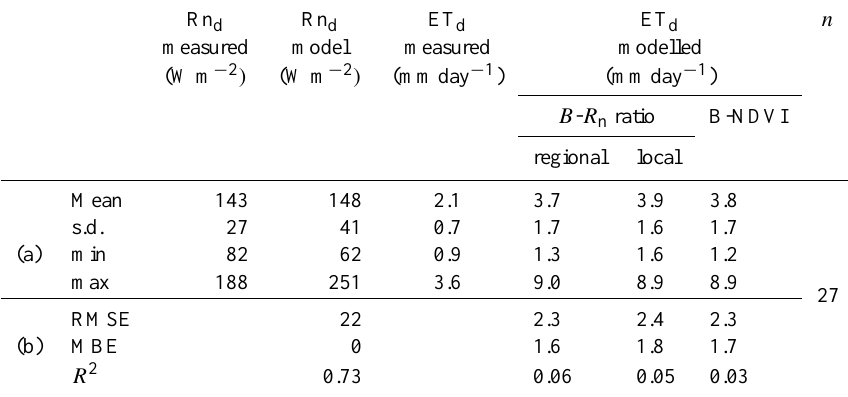
Table 3. (a): Descriptive statistics of daily net radiation (Rn d ) and daily evapotranspiration (ET d ) measured over the Scots pine stand, and AQUA MODIS Rn and ET d modelled using 3 methods: B - R n ratio regional, B - R n ratio local and B-NDVI (see text). (b) Model validation